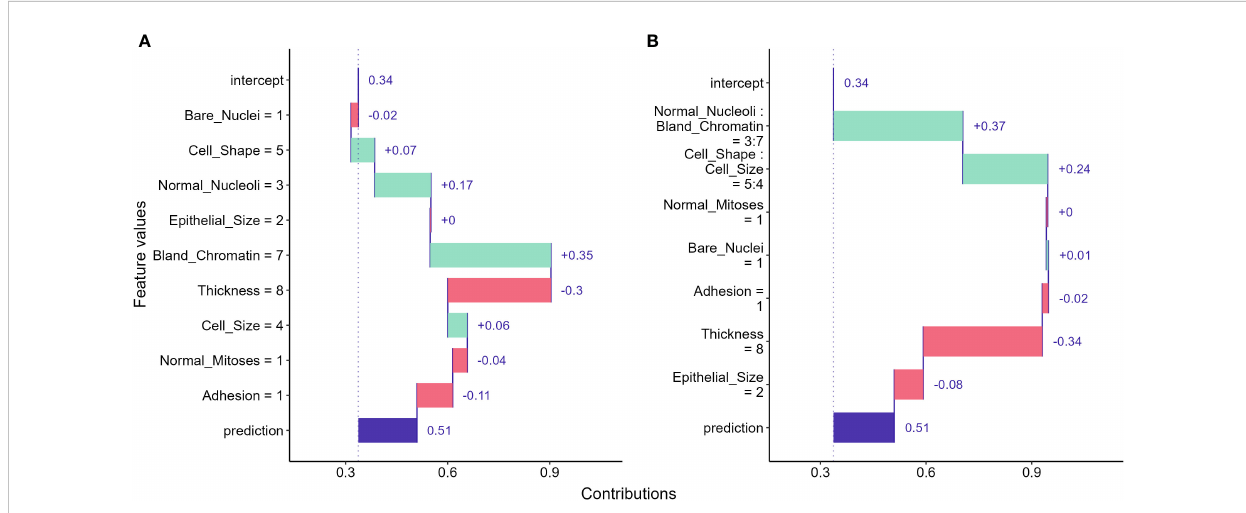
FIGURE 6 Break down (BD) plots showing how the contributions attributed to individual features for the instance we selected. (A) break down plot assuming no interactions among features; (B) break down plot with feature interactions considered.